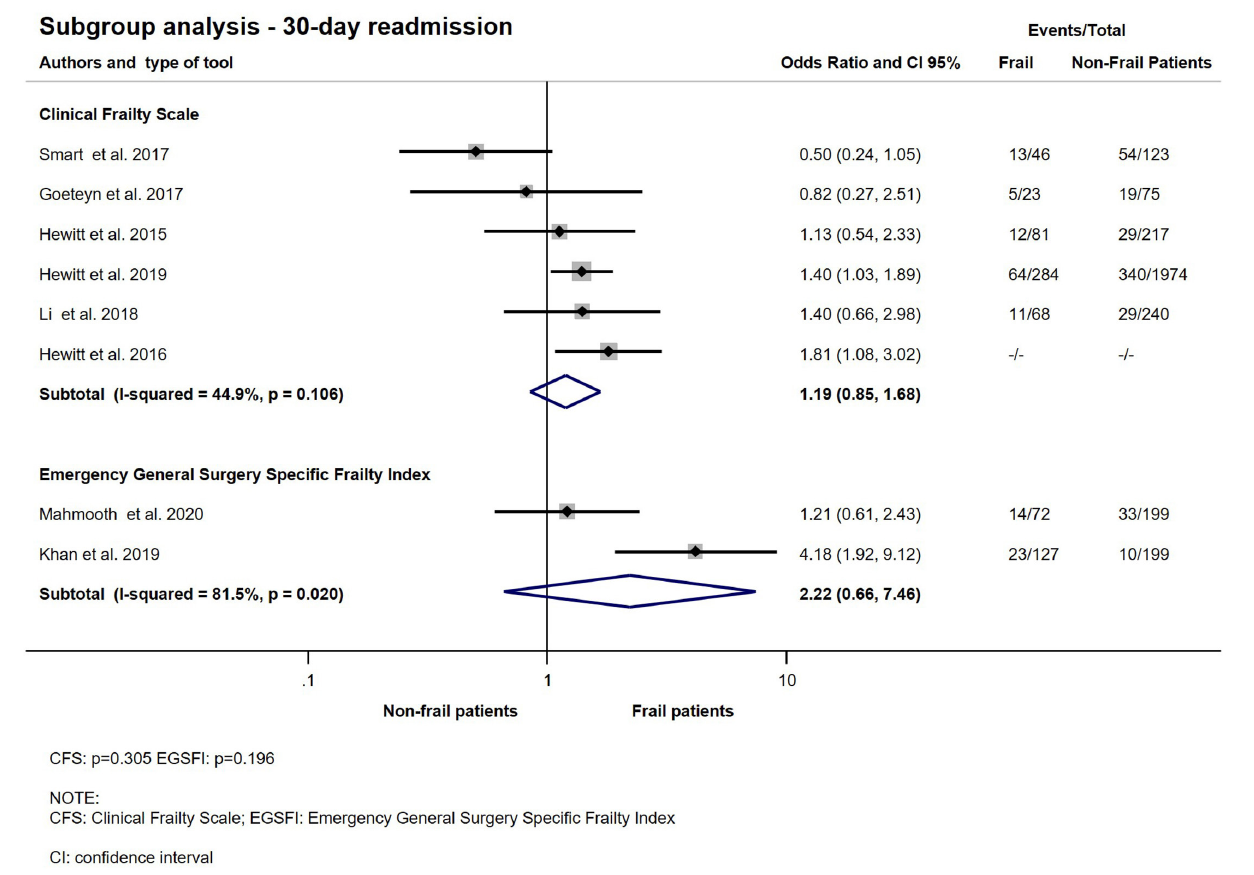
FIGURE 10 | Subgroup analysis − 30-day readmission for emergency surgical patients living with frailty compared to non-frail patients. Frail patients do not have significantly higher odds of 30-day readmission (CFS: OR: 1.19; CI: 0.85–1.68) and (EGSFI: OR: 2.22; CI: 0.66–7.46). From the study of Hewitt et al. (23) a crude OR was pooled with the ORs calculated from raw data. Note that heterogeneity was moderate in the CFS group but considerable in the EGSFI